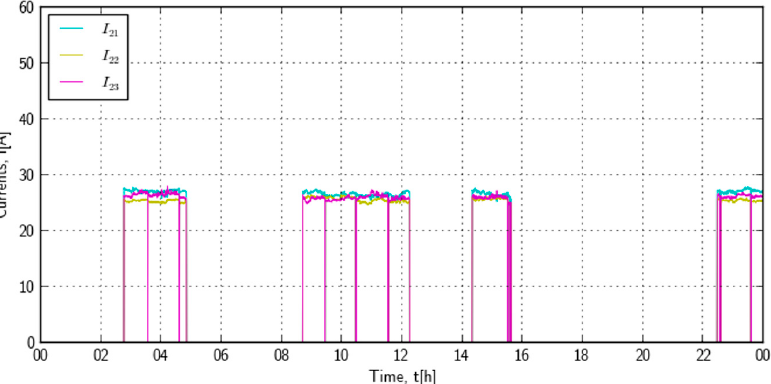
Figure 23. The simulation of the PU2 load current changes on 21 June 2009. (n = 2, t 1 = 15 min).